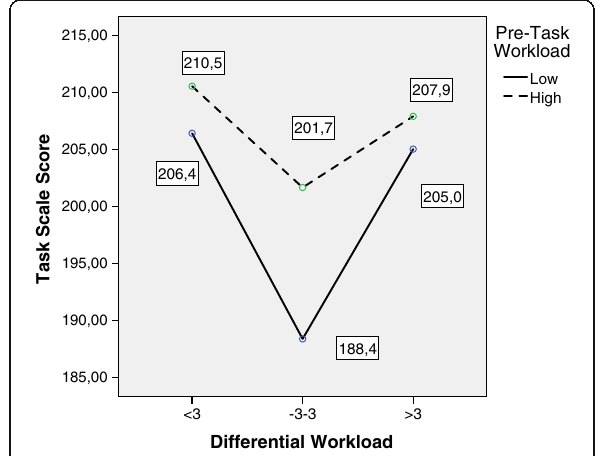
Fig. 7 MANOVA. Estimated marginal means. Differential Workload vs. Decision-Making Questionnaire Context scale. DMQ